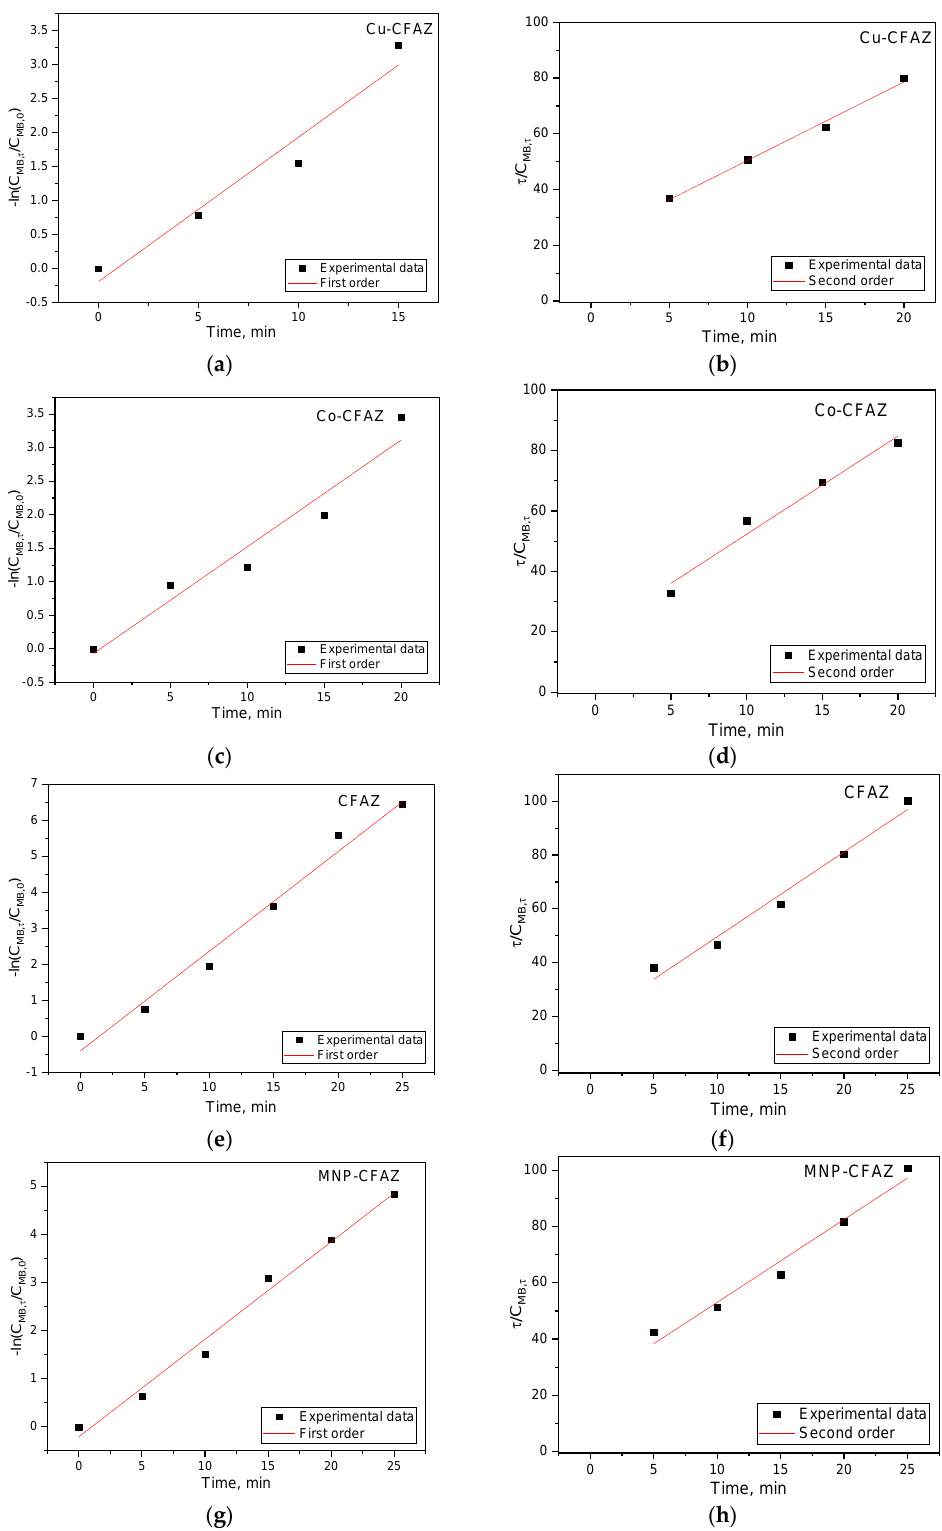
Figure 10. Pseudo first (PFO)- and second-order (PSO) reaction kinetics for degradation of MB by Fenton reaction onto CFAZ and modified CFAZ catalysts: ( a ) PFO of sample Cu-CFAZ; ( b ) PSO of sample Cu-CFAZ; (c) PFO of sample Co-CFAZ; ( d ) PSO of sample Co-CFAZ; ( e ) PFO of sample CFAZ; ( f ) PSO of sample CFAZ; ( g ) PFO of sample MNP-CFAZ; ( h ) PSO fo sample